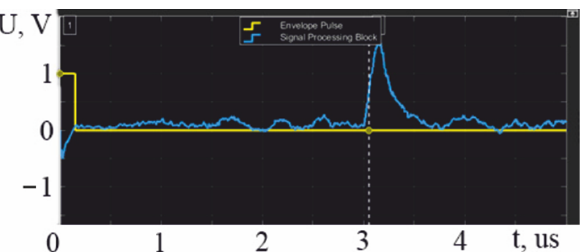
Figure 4. The time relationship between the emitted radio pulse envelope (yellow line) and the received reflected radio pulse envelope (blue line), the delay between which allows you to calculate the altitude to the underlying surface.